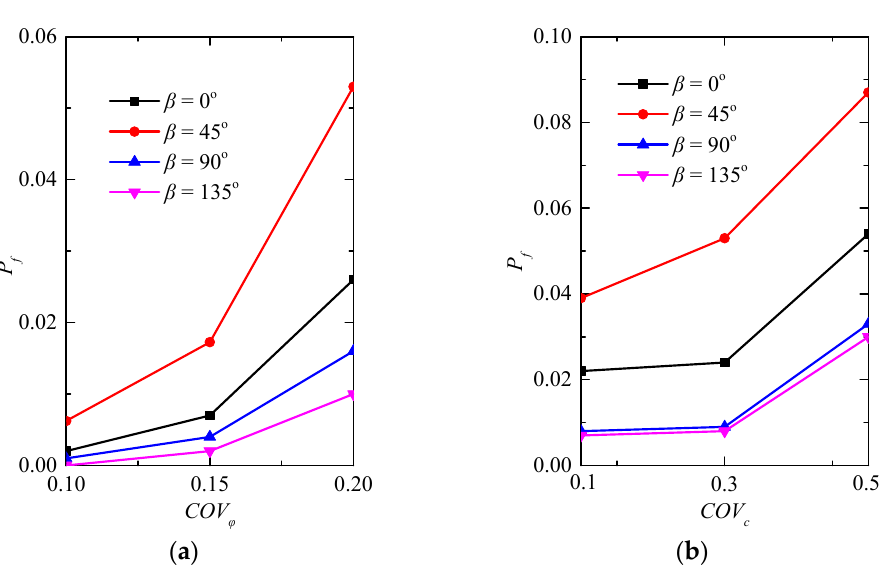
Figure 18. Failure probability with different coefficients of variation and random field rotation angles. ( a ) coefficient of variation for friction angle; ( b ) coefficient of variation for cohesion.